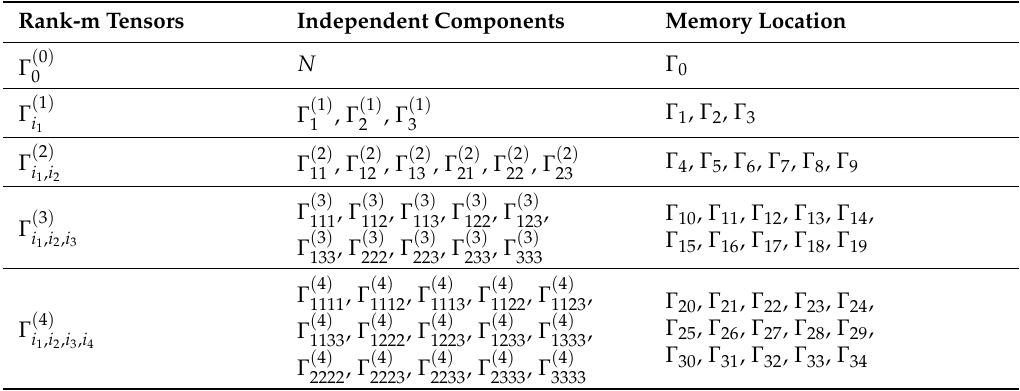
Table 1. List of the angular components and their memory locations. Row indices go over rows from top to bottom; column indices go over columns from left to right for a matrix.